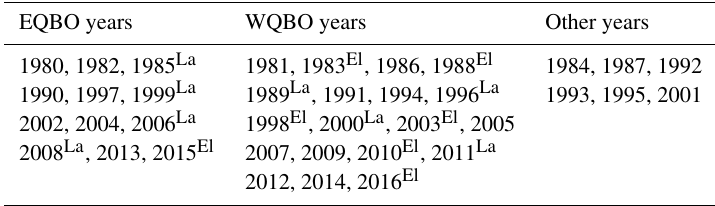
Table 1. List of EQBO, WQBO and other years categorized in this paper.